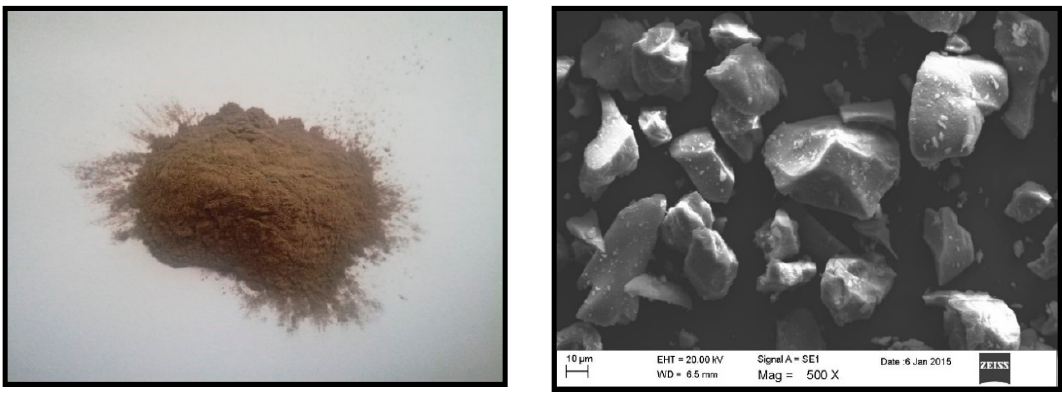
Figure 1. Raw palm oil ash from the hopper outlet of boiler.